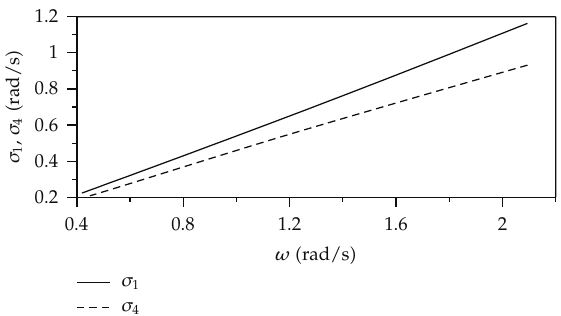
Figure 3: Two internal wave frequencies as functions of surface wave frequency ω , H (cid:8) 4m, γ (cid:4) (cid:8) γ (cid:4)(cid:4) (cid:8) 0 . 83, and h (cid:8) 0 . 1m.